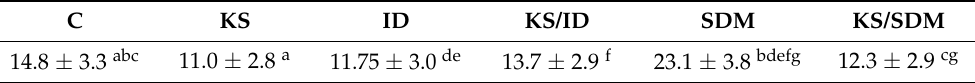
Table 1. The mean fodder intake by the rats of different experimental groups ( n = 12,